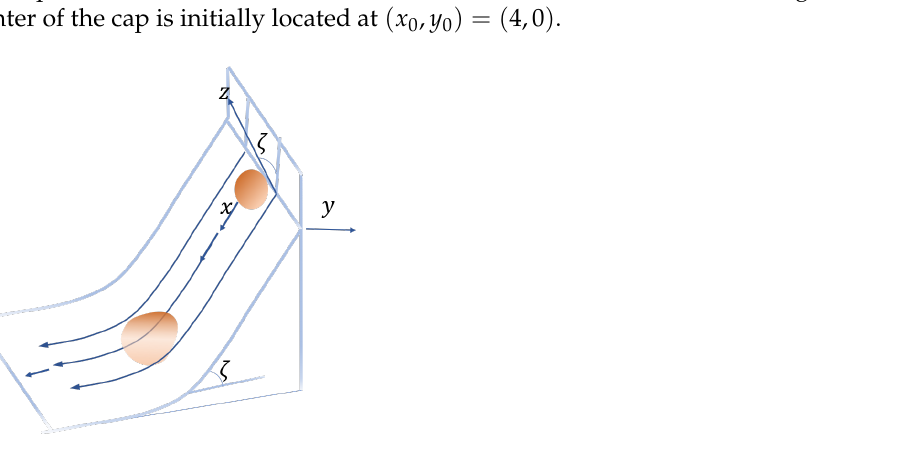
Figure 9. Sketch of the avalanche flow sliding down an inclined plane and merging continuously into a horizontal plane.